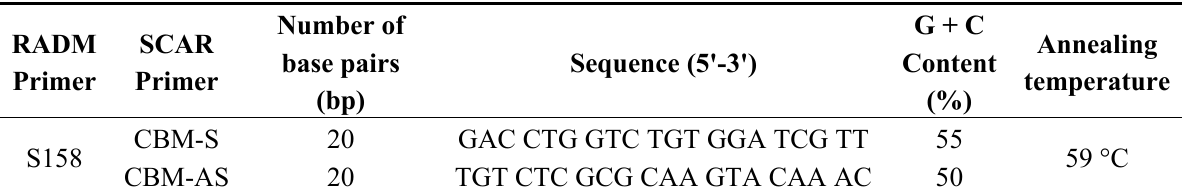
Table 2. Specific SCAR primer of Bulbus Fritillariae Cirrhosae devised from sequenced RAPD amplicon CBM08.